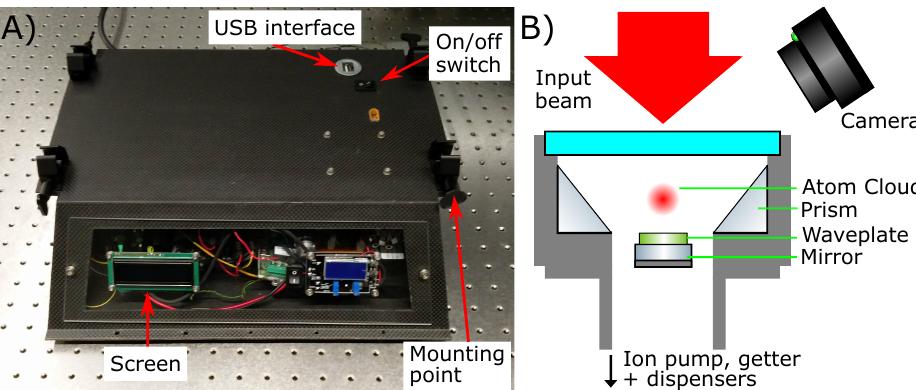
Figure 1. ( A ) The compact MOT system, which is contained within a custom light weight carbon fibre enclosure with dimensions of 370 mm × 350 mm × 100 mm. ( B ) Schematic of the custom titanium science chamber in which the atom cloud is formed. The science chamber design is similar to that in reference [26]. A camera off axis to the input beam is used to observe the MOT through the same window as the input